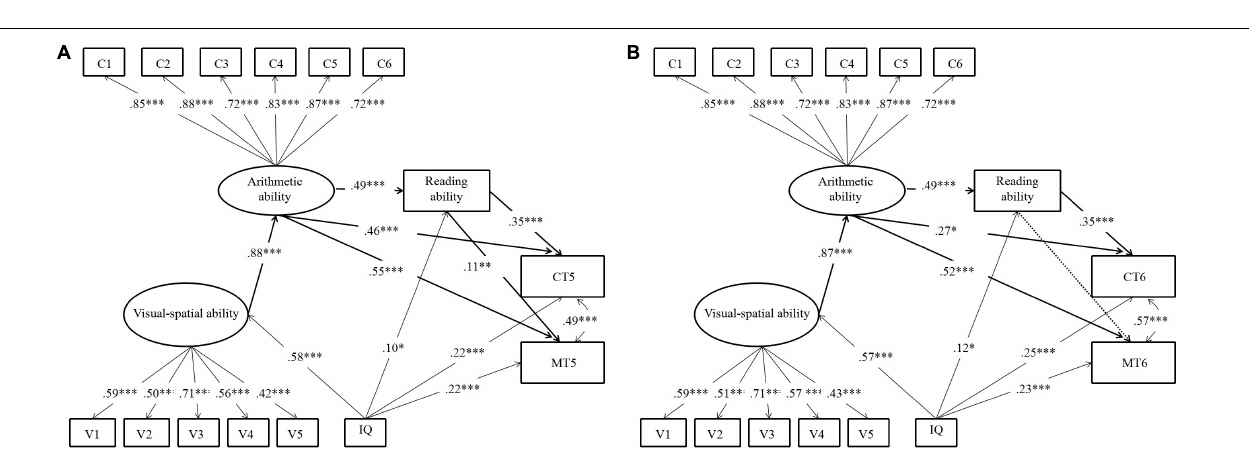
FIGURE 2 | Mediation effects of arithmetic and reading abilities between visual–spatial ability and academic achievement concurrently (A) and longitudinally (B) . V1–V5: number continuation; visual length; figure counting; square counting; number connection. C1–C6: addition; subtraction; multiplication; division; comparison; blank filling. MT5: math curriculum test in the fifth grade; CT5: Chinese curriculum test in the fifth grade. MT6: math curriculum test in the sixth grade; CT6: Chinese curriculum test in the sixth grade. Twin-headed arrows represent correlations between variables. One-headed arrows represent significant paths; non-significant paths are not represented. ∗ p < 0.05, ∗∗ p < 0.01, ∗∗∗ p < 0.001.